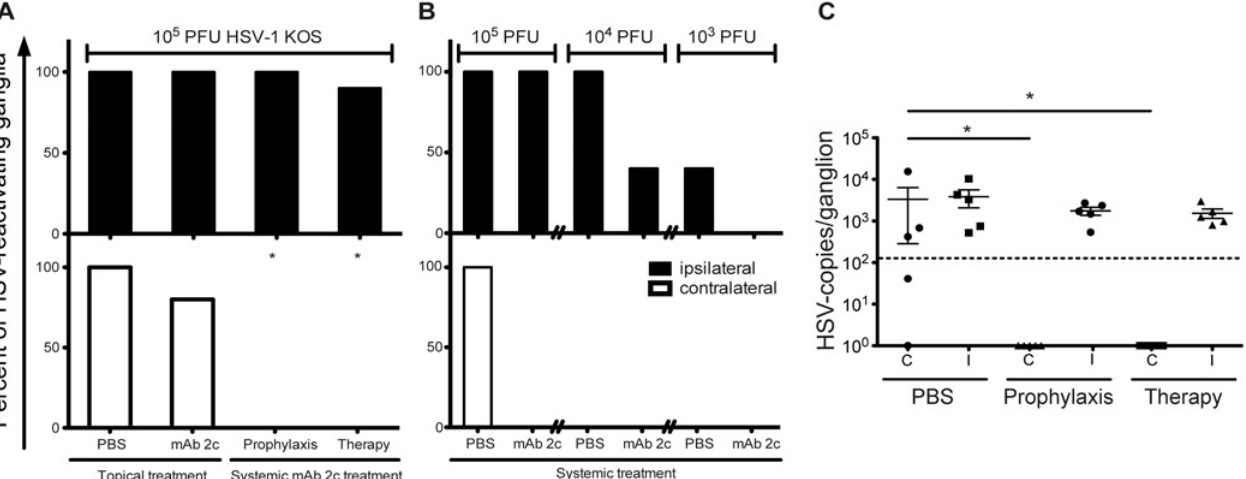
Figure 10. Reduced extent of HSV reactivations from trigeminal ganglia of mice systemically treated with mAb 2c. (A) Percentage of reactivating ipsilateral or contralateral trigeminal ganglia from HSV ‑ 1 KOS infected mice is shown. Trigeminal ganglia were isolated on day 14 after infection and co- cultured with confluent Vero cells for three weeks to investigate the reactivation of virus. The occurrence of a cytopathic effect was taken as proof of virus reactivation. Each group consisted of ten mice. The differences in the total numbers of reactivating virus between the ipsilateral and contralateral ganglia were examined with Fisher´s exact test. Comparisons were considered significant at * P < 0.05. (B) Subsequent investigation of the impact of prophylactic mAb 2c application at 24 h before infection on the frequency of reactivating virus after infection with decreasing viral loads. Each group contained 5 mice. (C) Quantification of HSV-1 DNA in trigeminal ganglia isolated on day 14 after infection. Each group contained 5 mice. Statistical analysis was undertaken with a nonparametric ANOVA test. Comparisons were considered significant at * P < 0.05. Error bars represent the standard error of the mean. I = ipsilateral; C =